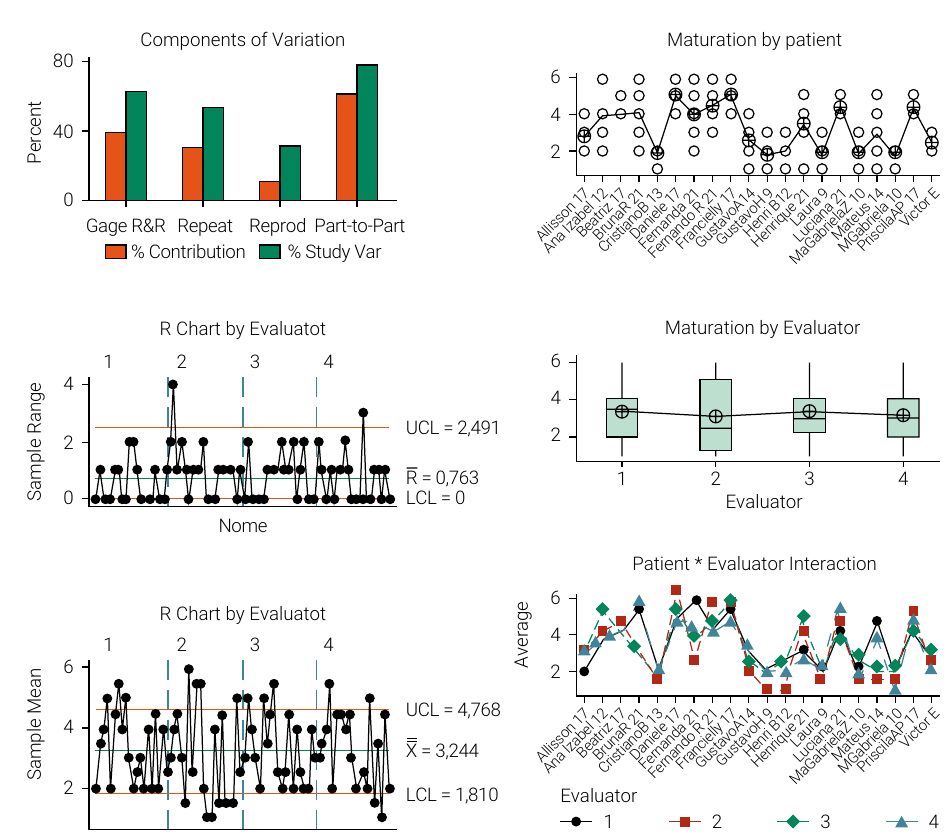
Figure 2. Study of repeatability and reproducibility of the